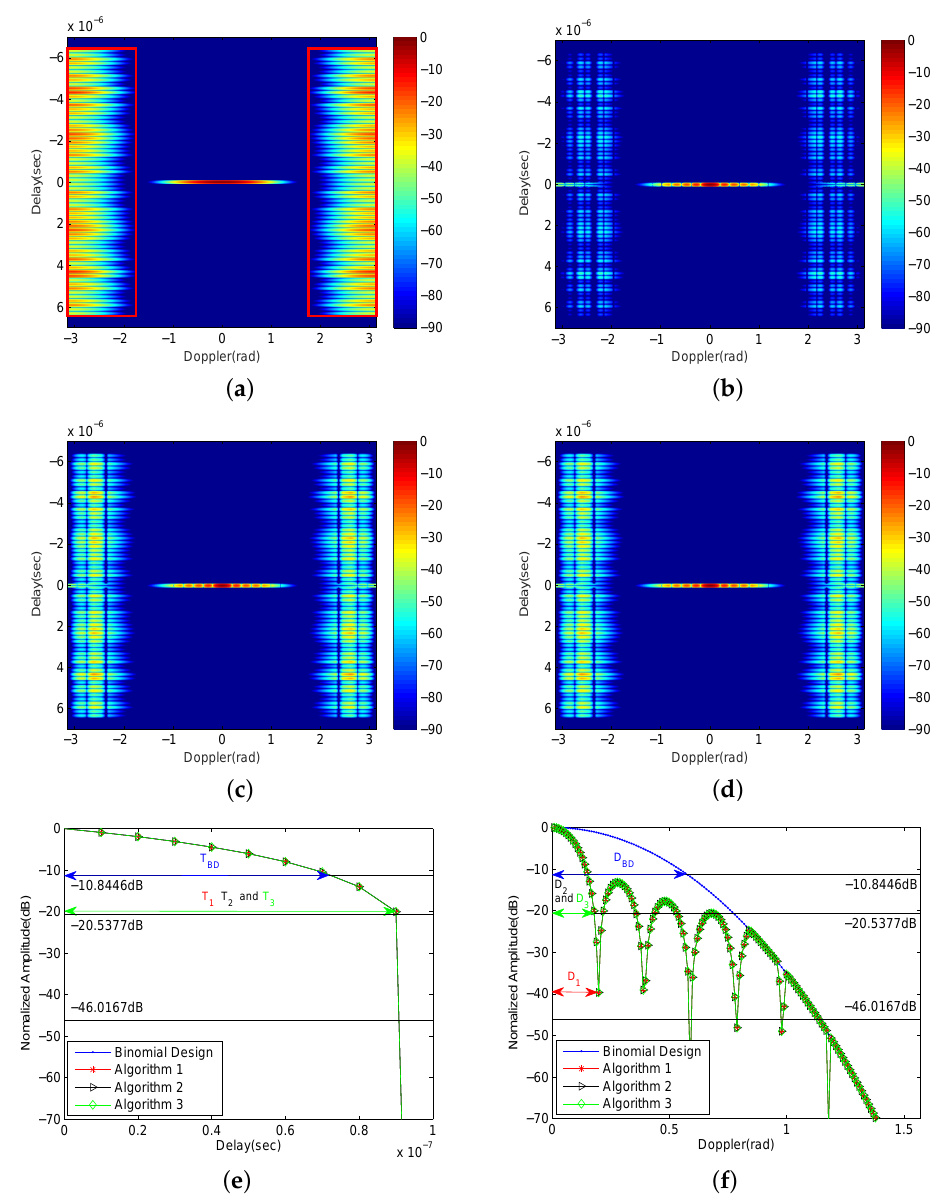
Figure 5. The AFs of ( a ) Binomial Design algorithm; ( b ) Algorithm 1; ( c ) Algorithm 2; ( d ) Algorithm 3; and the comparisons of ( e ) delay mainlobes/zero-Doppler cross section; and ( f ) Doppler mainlobes/zero-delay cross section (the unit of colorbar is